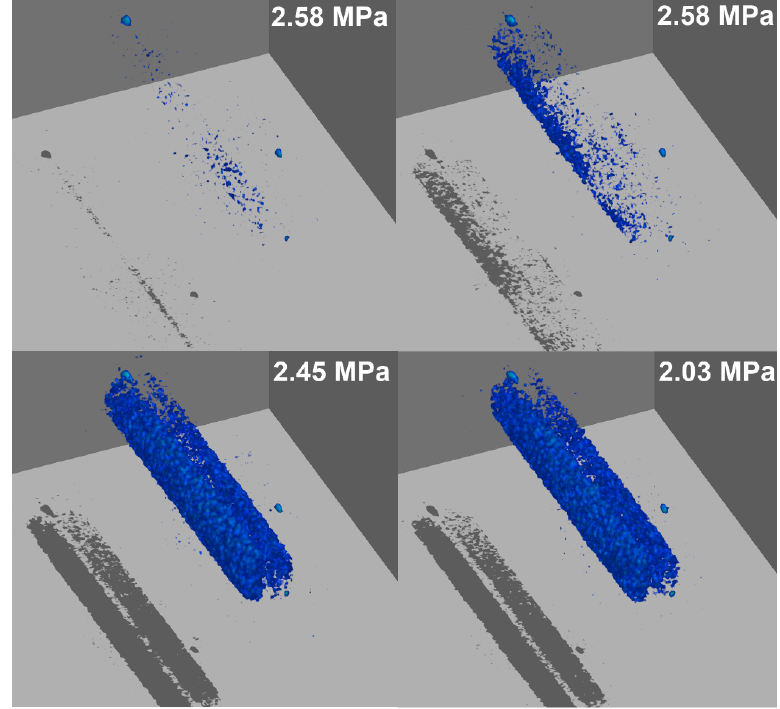
Figure 11. Decomposition of cycle c2 occurred mainly at 2.58 and 2.45 MPa, thus indicating a conversion of approximately 60 mol% CO 2